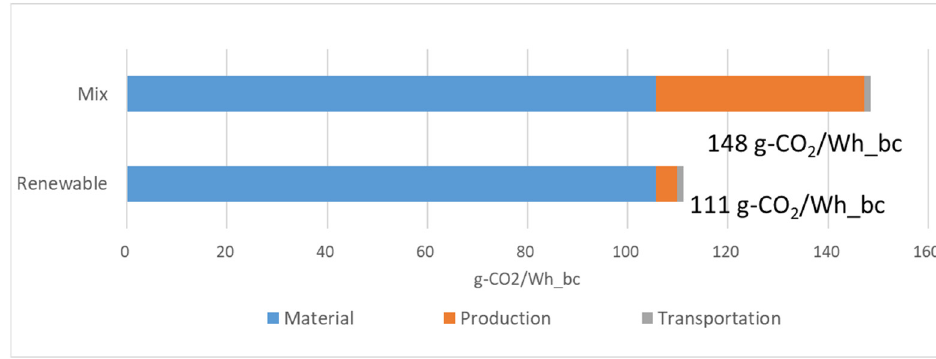
Figure 3. Material to production CO 2 emissions per battery unit storage capacity.